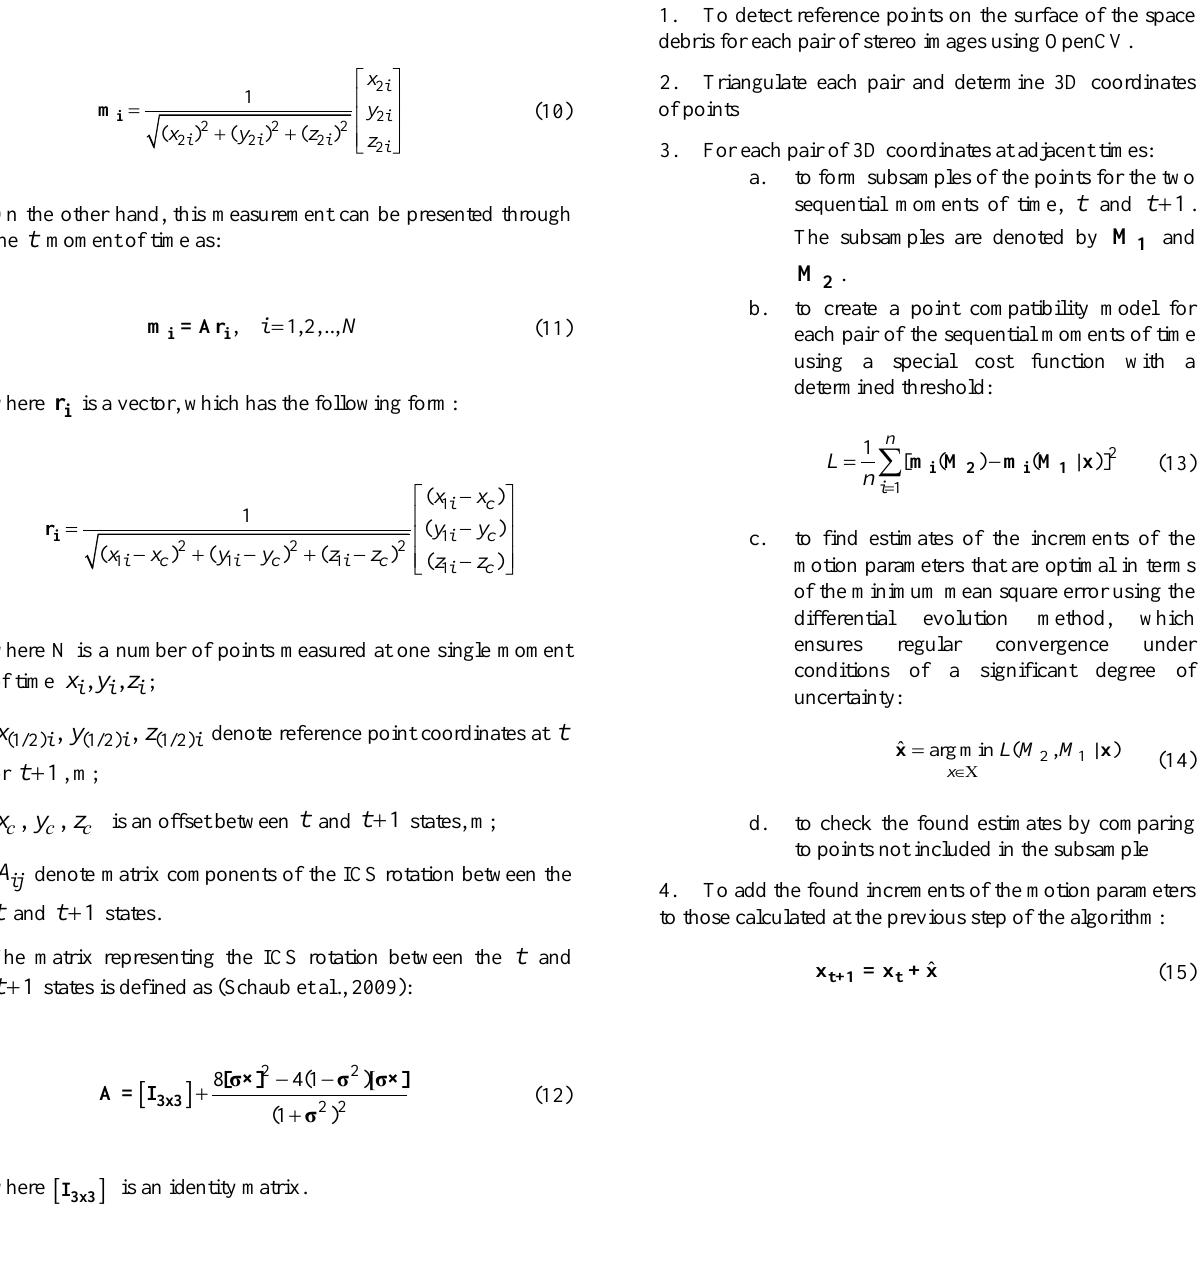
Figure 2 . Coordinate systems and reference points A measurement at